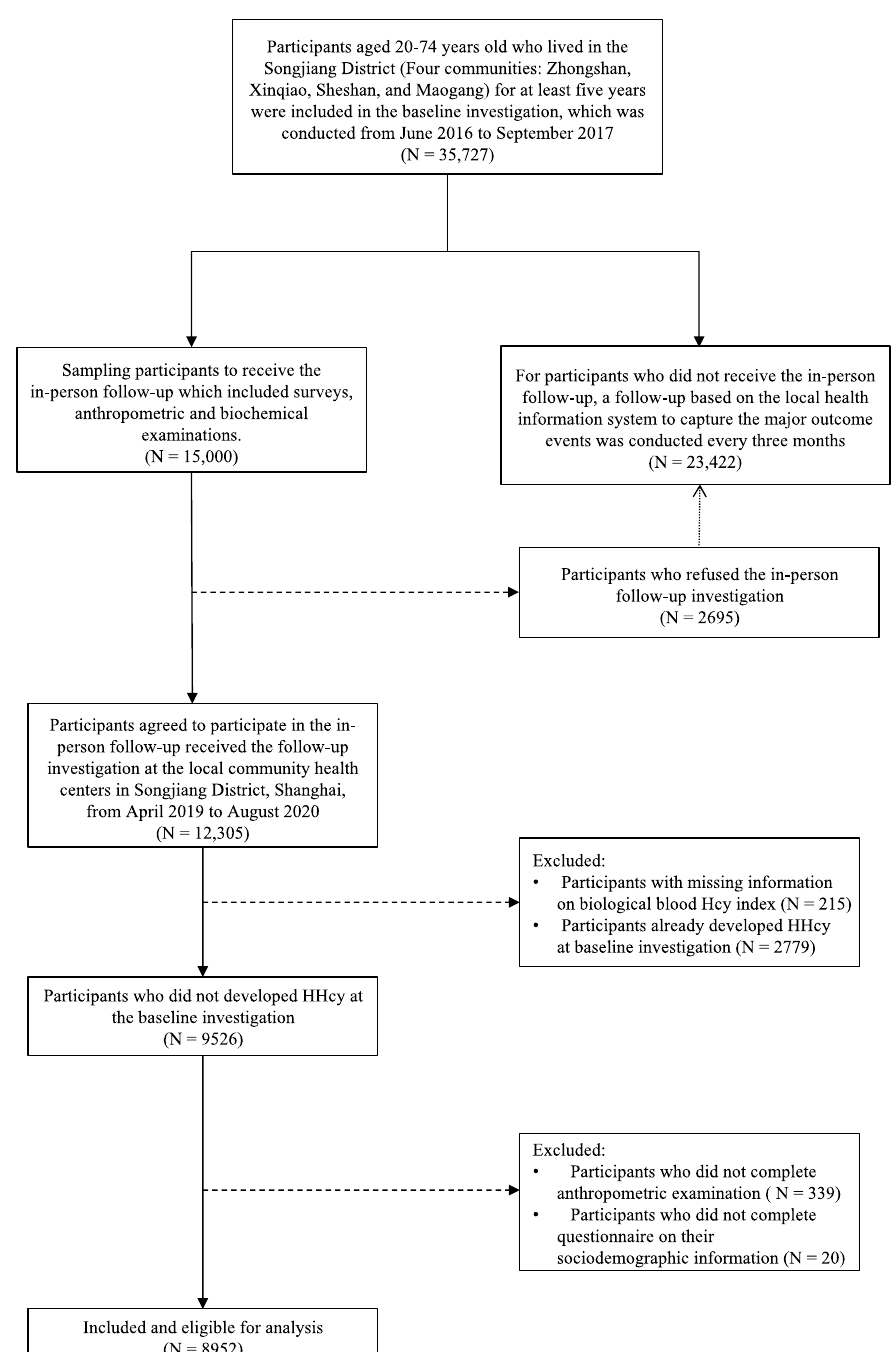
Figure 1. Flowchart of the study participants